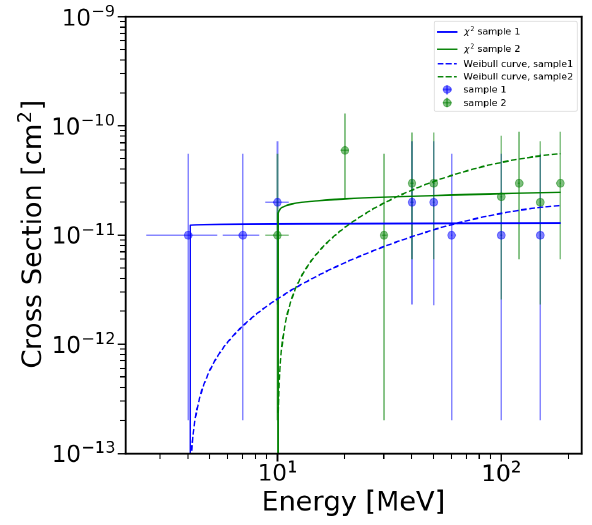
Figure 9. SEFI cross section together with the Weibull fit function.